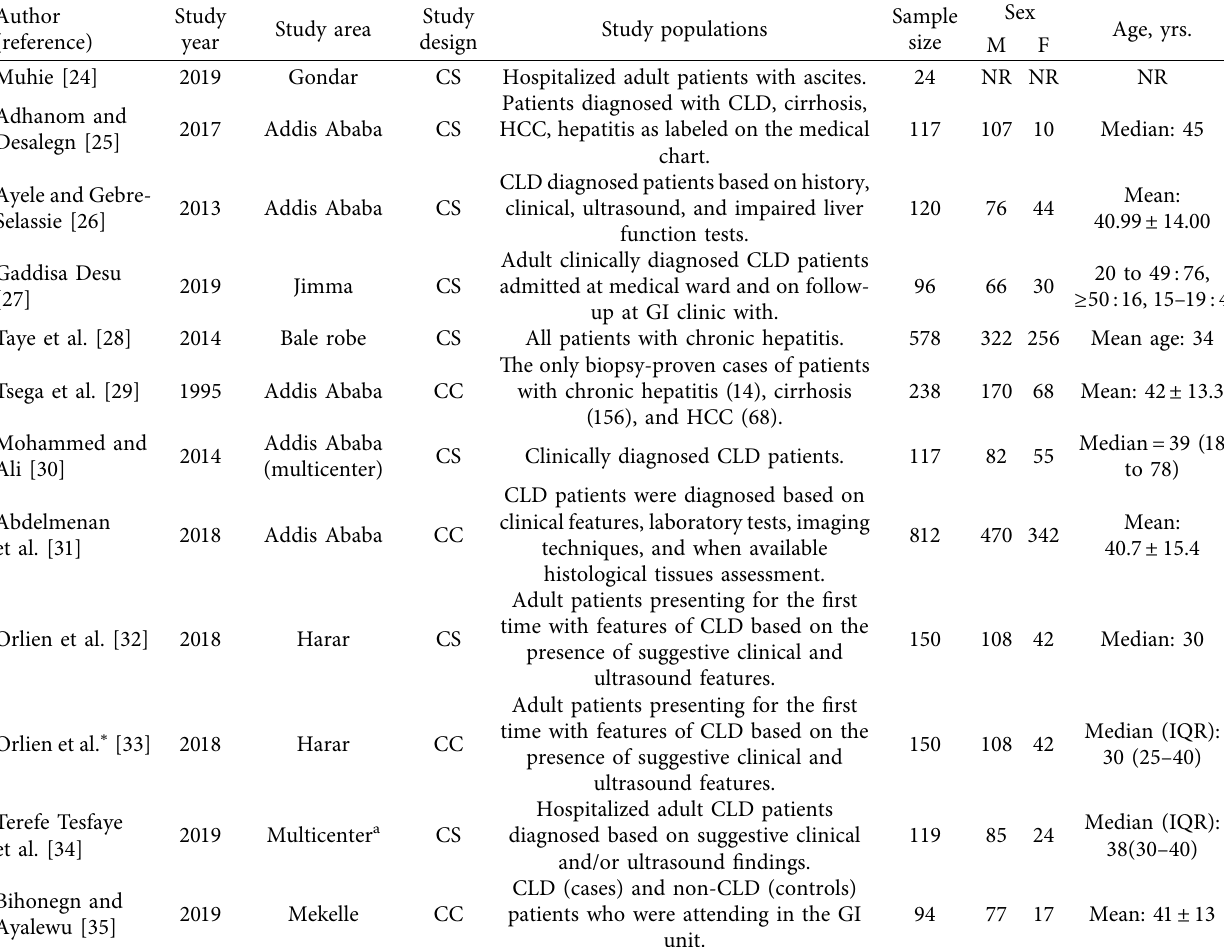
Table 2: Study characteristics and populations included in the eligible studies.